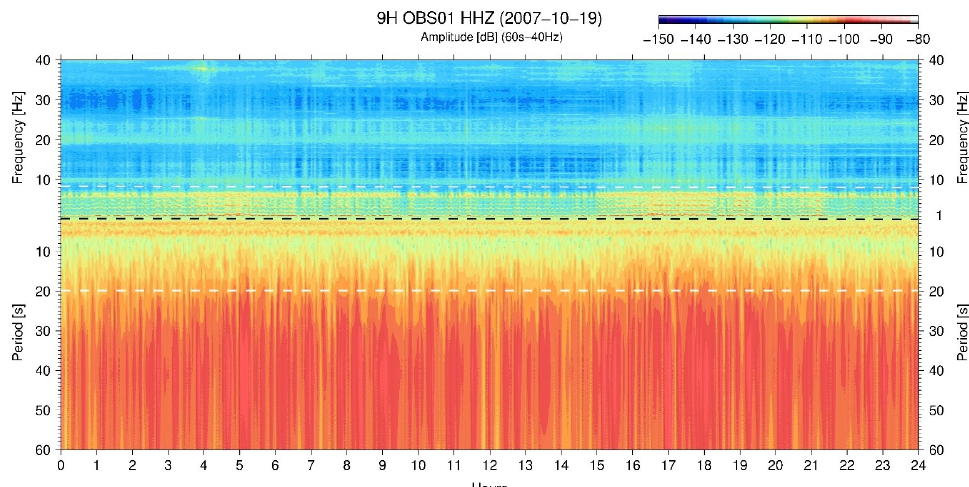
Figure 1. Noise bands – inside the short-period band, from 0.5 to 6.5Hz, we show long-lasting harmonic tremor signals frequently observed in spectrograms of OBS data with overlapping frequency content with earthquake detection events. The long-period band from the 20–60s shows the tilt noise and the microseism noise band between 2 and 20s. The harmonic tremors, microseism and tilt noise are shown in this particular OBS data record and are continuously observed in a one-day spectrogram (OBS01). The spectrogram is between 40 and 0.0167Hz (60s), however, between 1 and 0.0167Hz converted to the period in seconds with linear axes. The amplitude unit is m 2 s − 4 Hz − 1